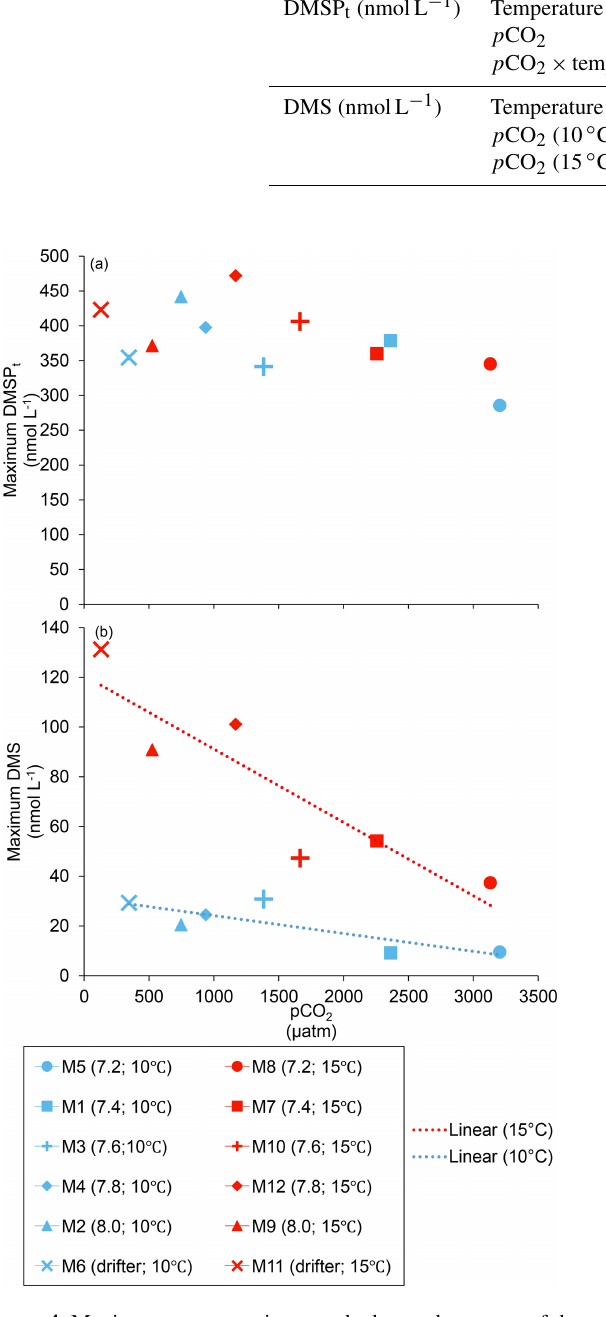
Figure 4. Maximum concentrations reached over the course of the experiment for (a) DMSP t and (b) DMS. For symbol attribution to treatments, see the legend.